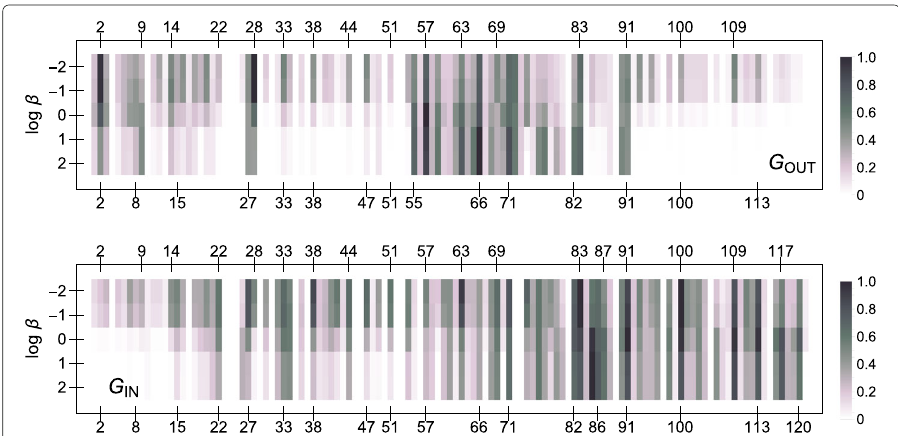
Fig. 4 Fingerprint maps of the key concepts in the collated concept network. The key concepts having a high communicability are shown as black stripes. The weighting of links with β = 10 p changes from p = − 2 to p = 2 as shown on the scale on the right. The communicability through out-going links (OUT) is shown in the upper panel and through in-coming links (IN) in the lower panel. Numbering of nodes is given in upper- and lower sides of the stripes. The colour-legend for relative strengths of communicability is provided on the right. Note how differently weighted networks have different sets of key nodes. The key nodes surviving after the strong epistemic weighting region are the most strongly supported/supporting